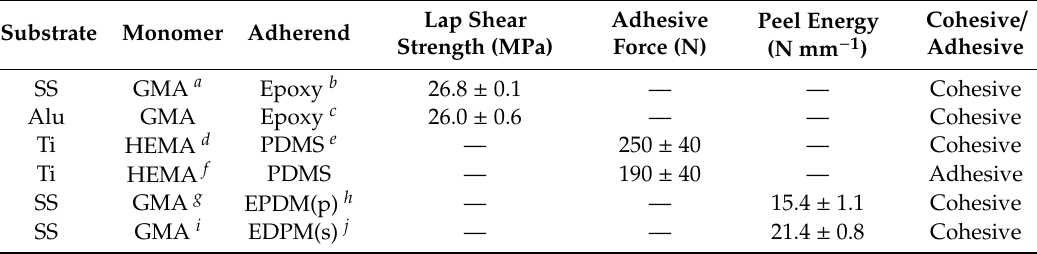
Table 3. Various material combinations with bonding relying on the cross-linking of polymer brushes with bulk